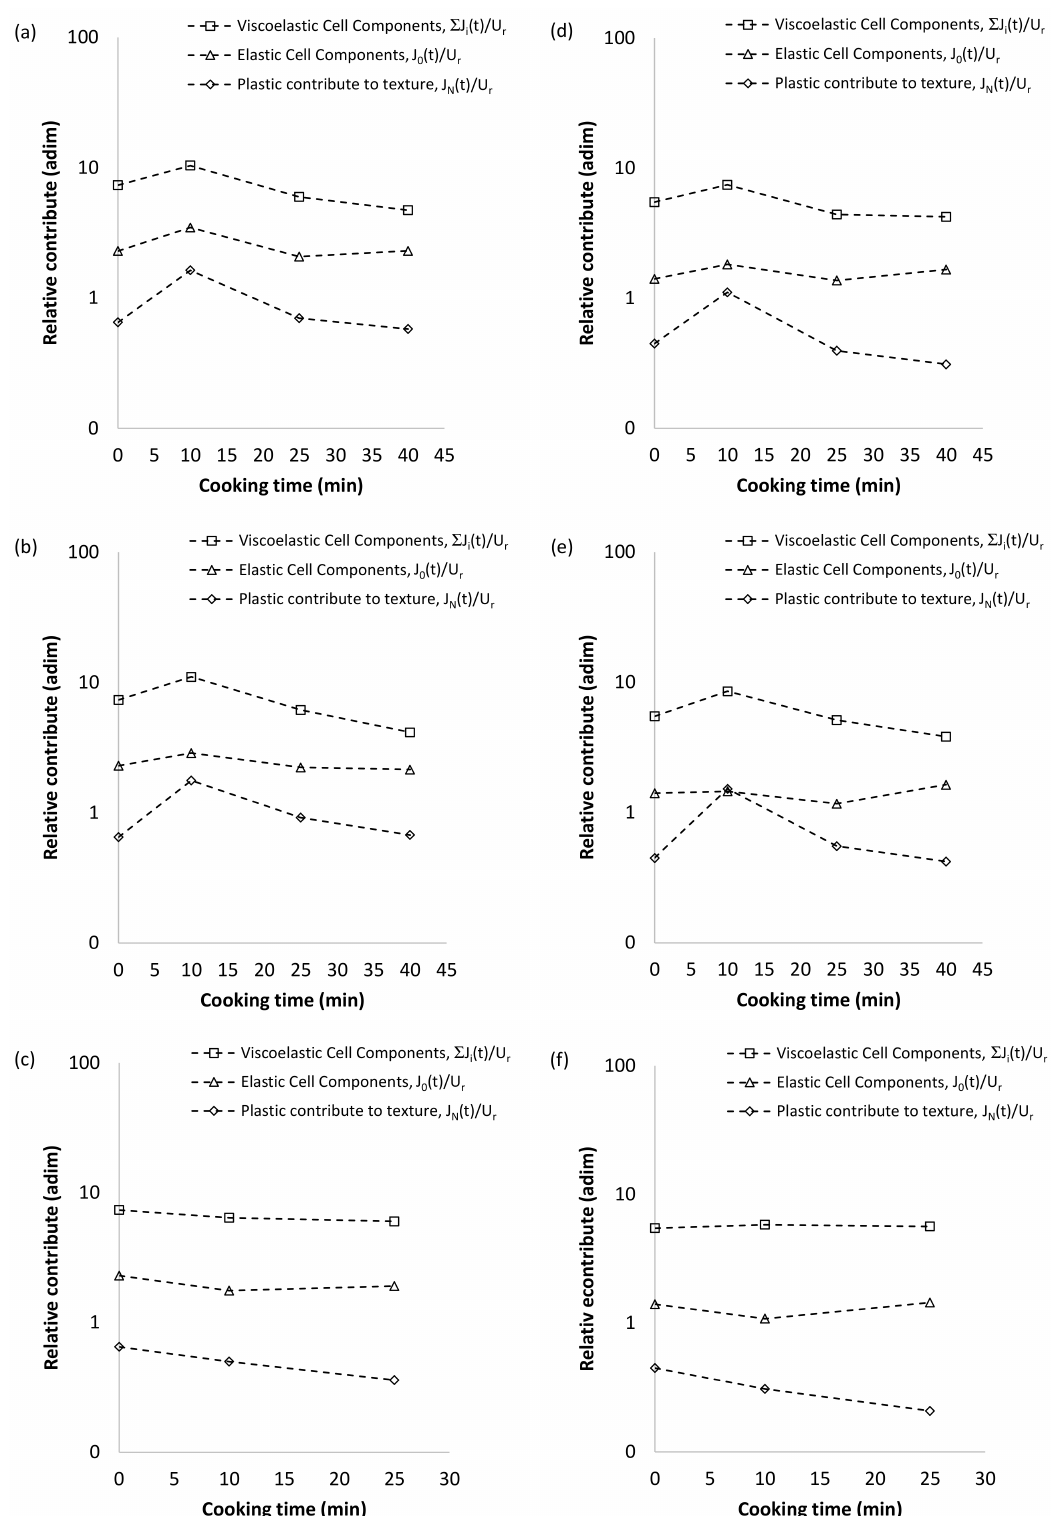
Figure 4. Relative contribution of the elastic, viscoelastic, and plastic cell elements to the overall creep compliance after steaming ( a , d ), sous-vide ( b , e ) and boiling ( c , f ) for Depurple (left) and Cheddar (right)